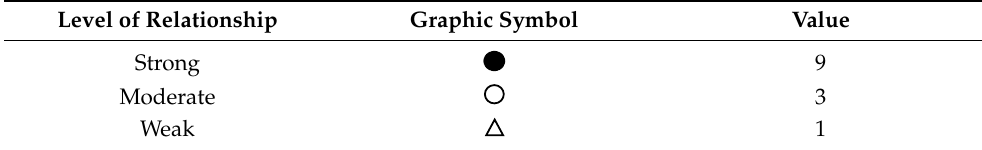
Table 4. Relationship scale symbol. Table 4. Relationship scale symbol. 431 Table 4. Relationship scale symbol. 431 Table 4. Relationship scale symbol. 431 Level of Relationship Graphic Symbol Value Level of Relationship Graphic Symbol Value Level of Relationship Graphic Symbol Value Level of Relationship Graphic Symbol Value Strong 9 Strong 9 Strong Strong Moderate 3 Moderate 3 Moderate Moderate Weak 1 Weak 1 Weak